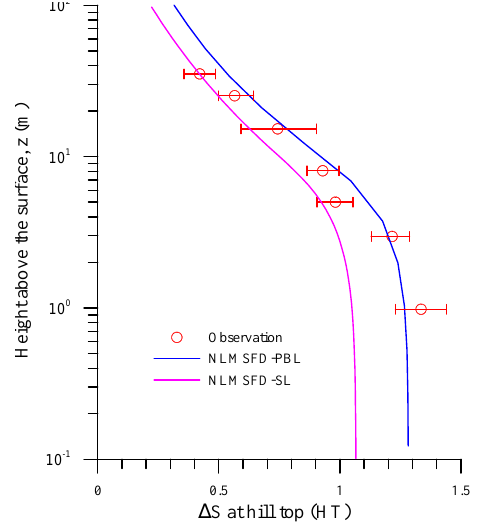
Figure 5. Vertical profile of fractional speed-up ratio, ∆ S , at the hill top (point HT) of Askervein hill. Comparison of model results and experimental data.